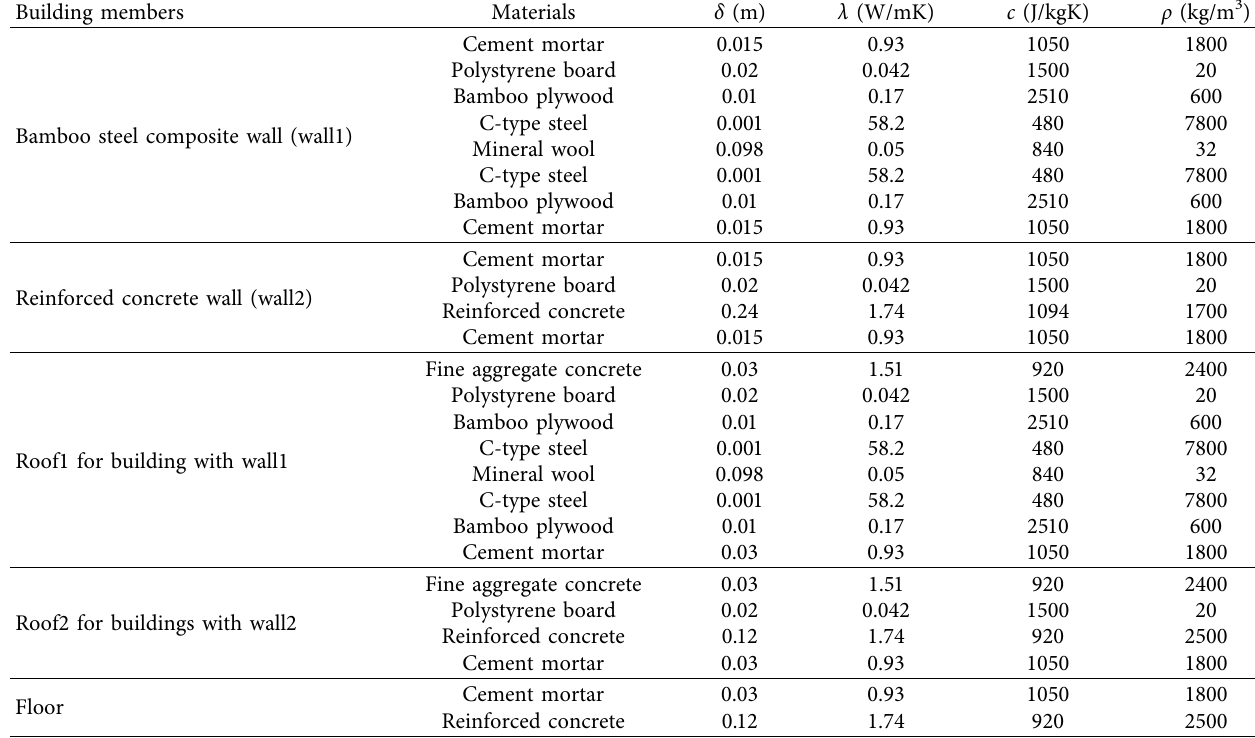
Table 1: Thermal properties of building